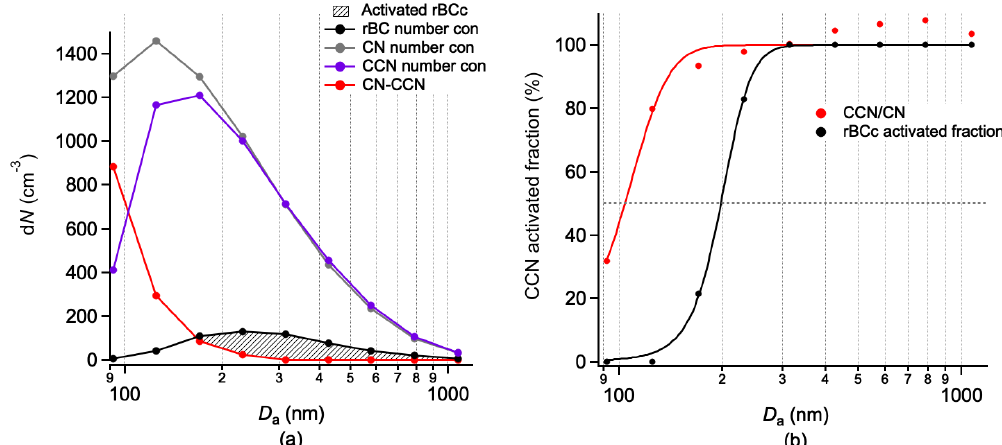
Figure 2. An example of all particles and activation of rBCc. The dashed grey line in (b) indicates 50% of all particles or rBCc activated.